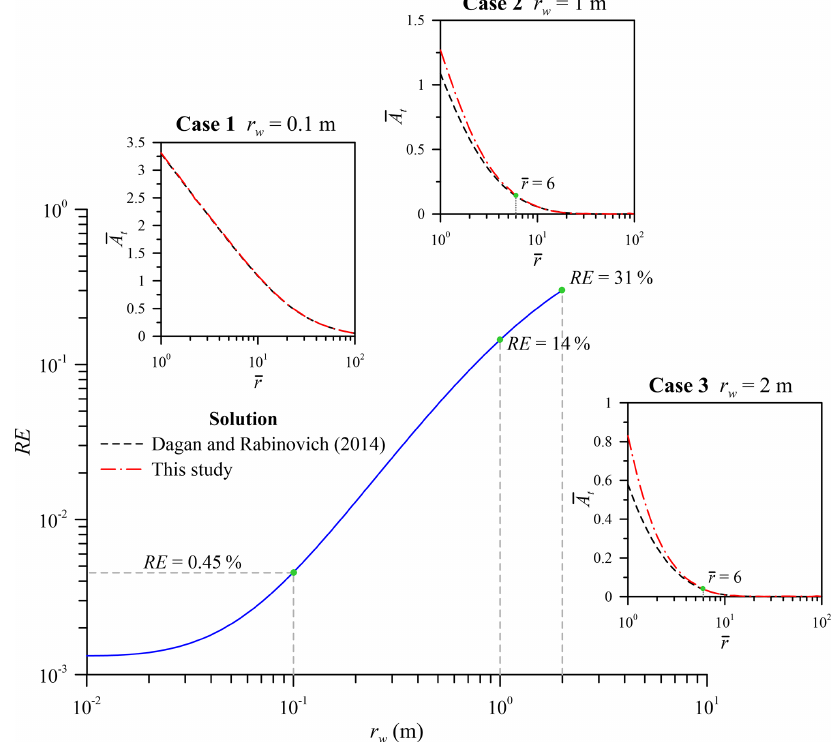
Figure 3. Relative error (RE) of the dimensionless amplitudes A t at the rim of the pumping well (i.e., r = r w ), predicted by IGD Solution 2 and the Dagan and Rabinovich (2014) solution. The well radius is assumed to be infinitesimal in the Dagan and Rabinovich (2014) solution and finite in our